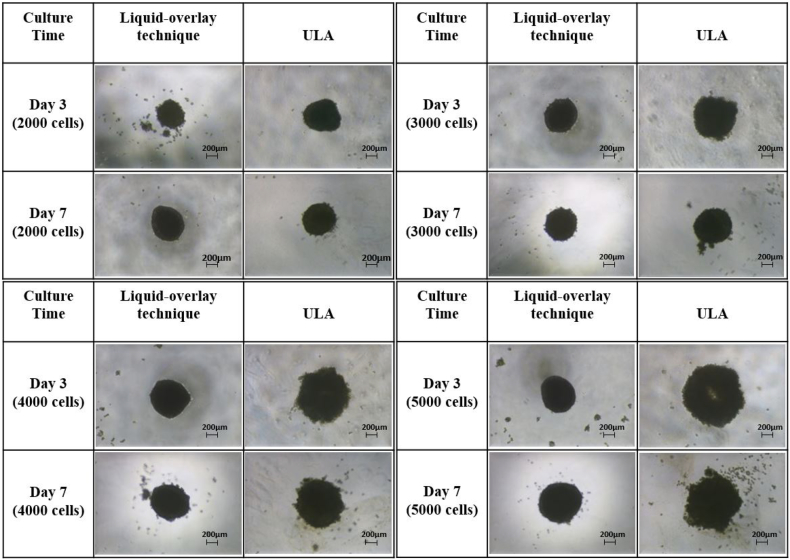
Formation and morphology of spheroid produced using the liquid-overlay technique (LOT) or ULA plates for different initial seeding cell numbers. Fig. 1 shows phase-contrast images of spheroids produced using 2000, 3000, 4000 and 5000 PRH at day 3 and day 7. Scale bar = 200 μm.